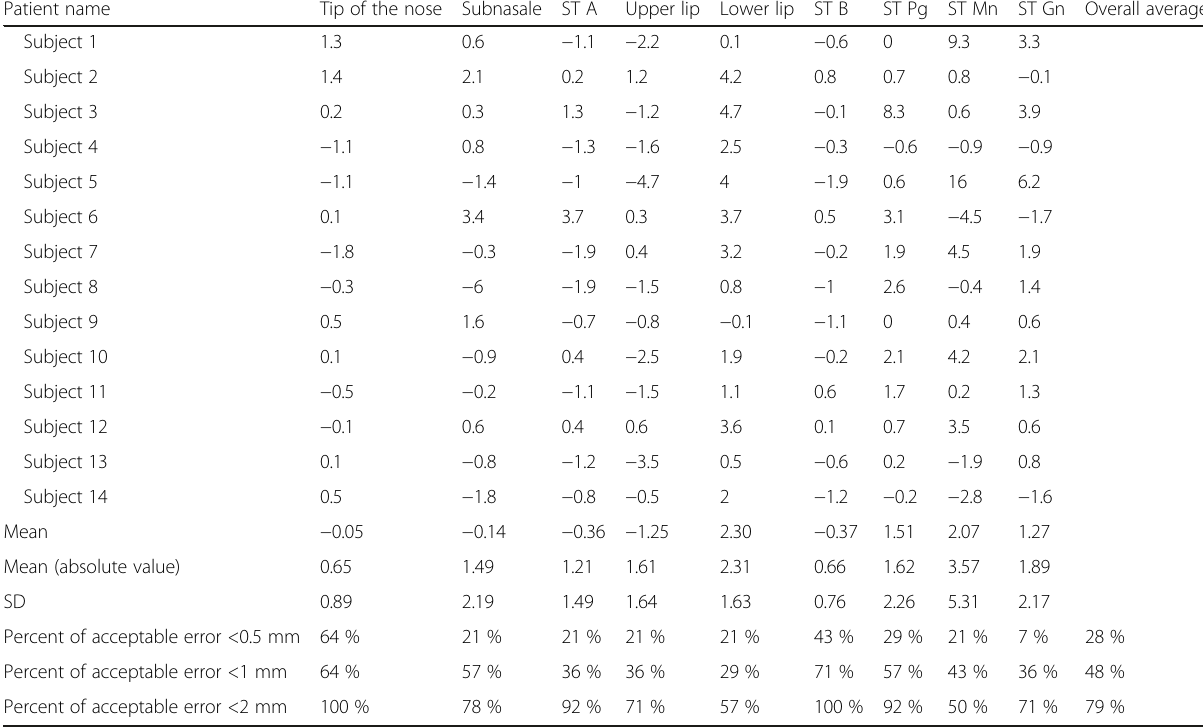
Table 2 Error of frequency of subjects and range of acceptable error in the X -axis Patient name